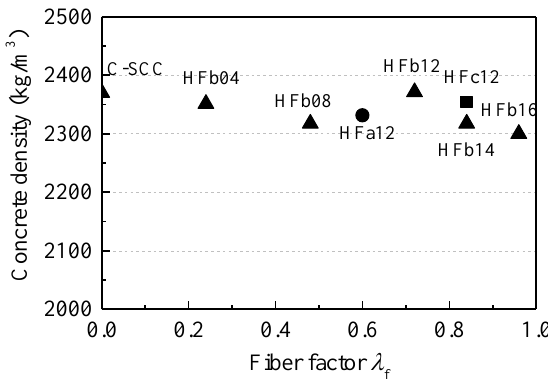
Figure 9. Variations of the density, along with the fiber factor.